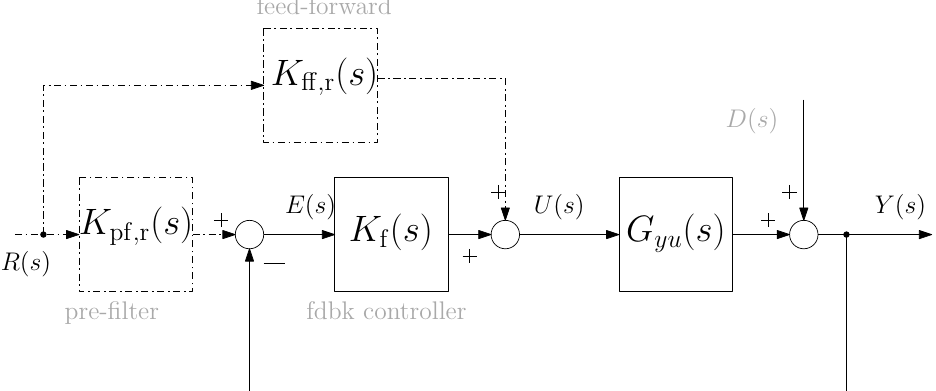
Figure 5. Typical 2-DoF feedback control framework.